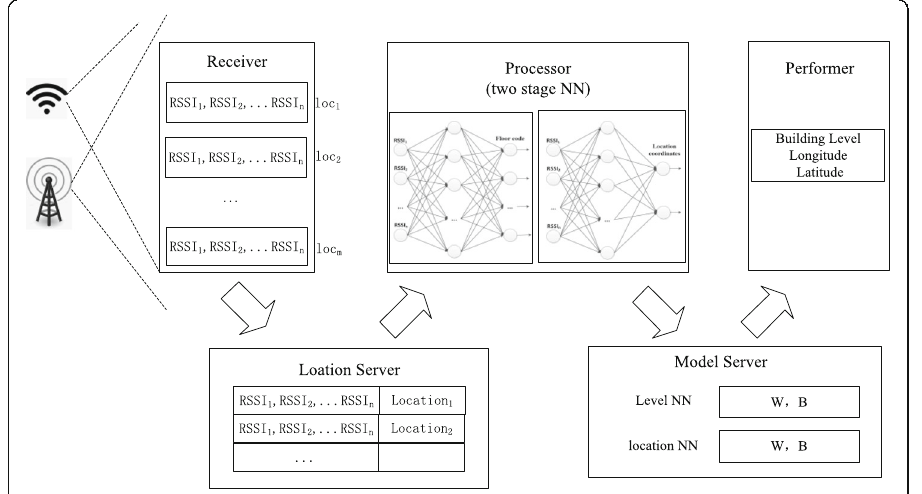
Fig. 1 Architecture of the proposed 3D mobile positioning